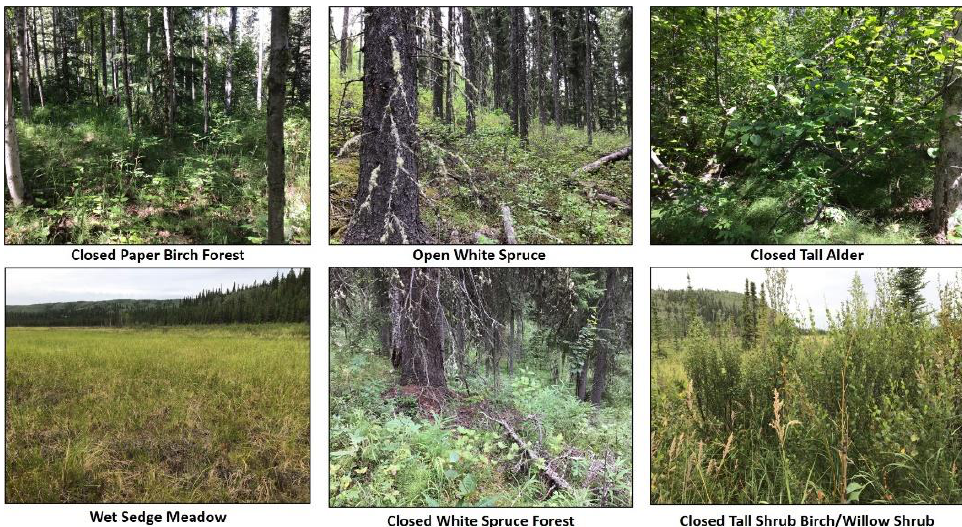
Figure 3. Field photos of select vegetation/fire fuel classes from interior Alaska.